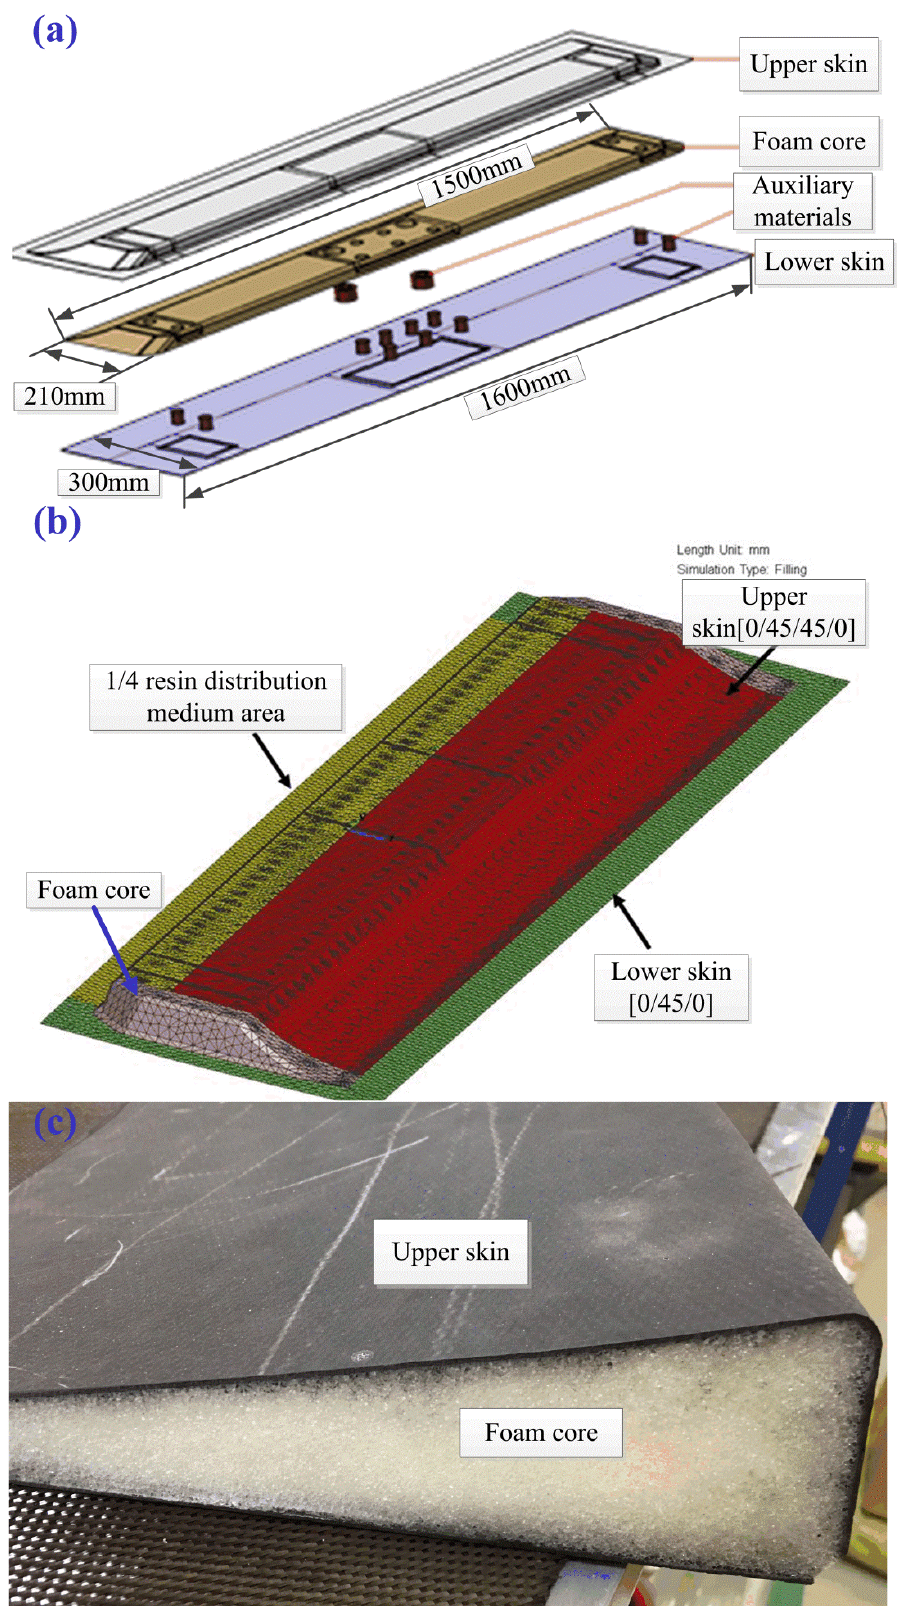
Figure 1. Schematic diagram of typical foam sandwich spoiler structure. ( a ) Spoiler structure; ( b ) simulation model; ( c ) spoiler prefabricated body.